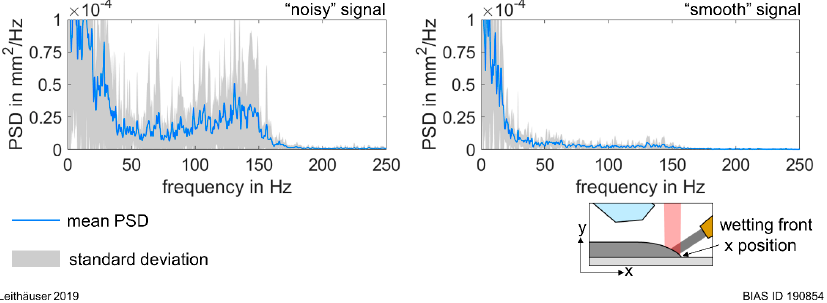
Figure 9. Mean PSD and standard deviation of the wetting front, including all samples with ( left ) and without ( right ) dominant frequencies between 160 and 400 Hz.